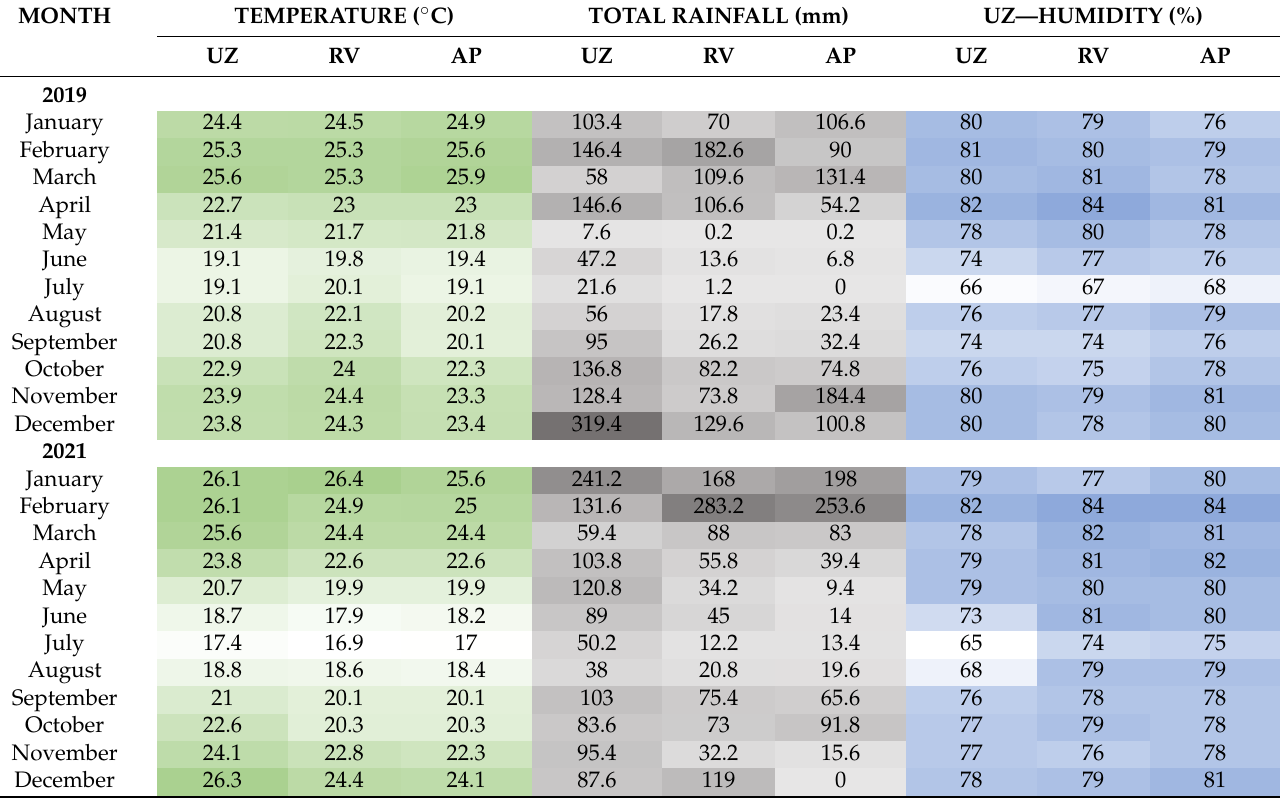
Table 1. Average monthly temperature, rainfall, and humidity in Ngwelezane, Dlangubo and Mtubatuba for the years 2019 and